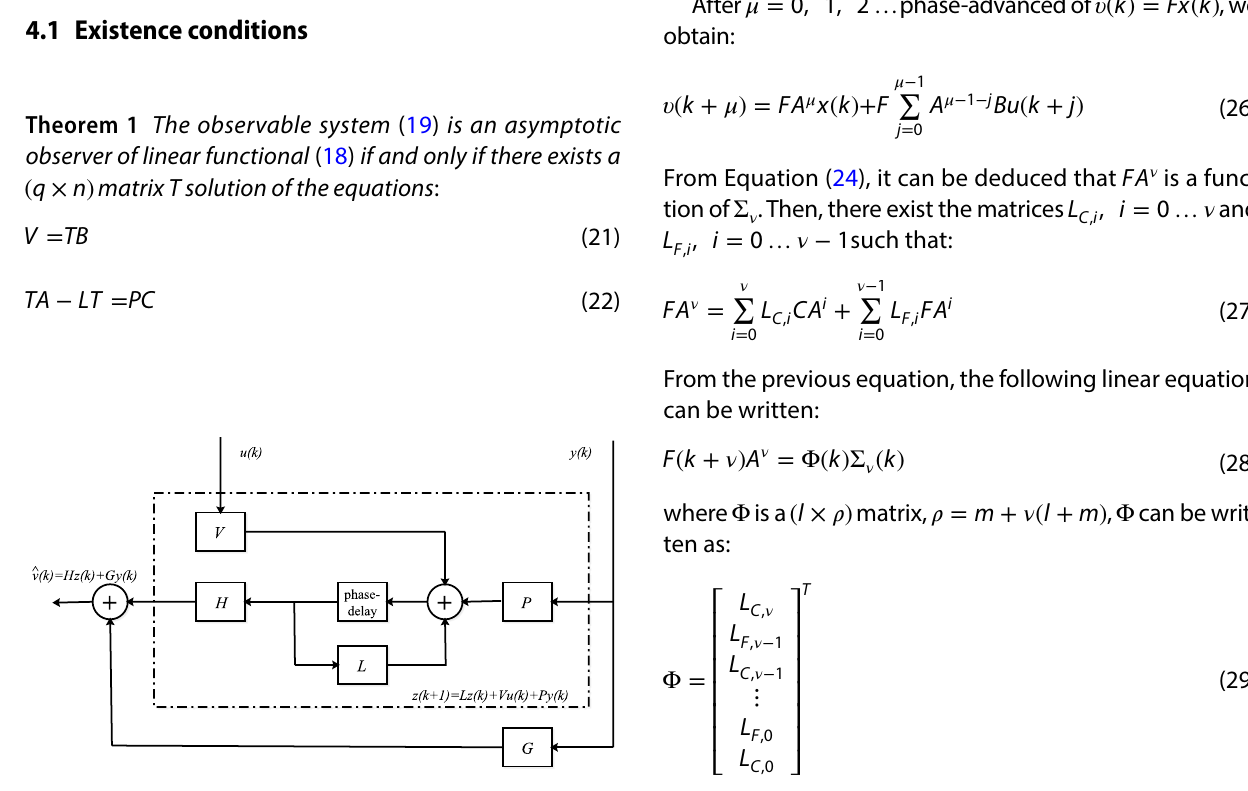
Fig. 6 Discrete linear functional observer